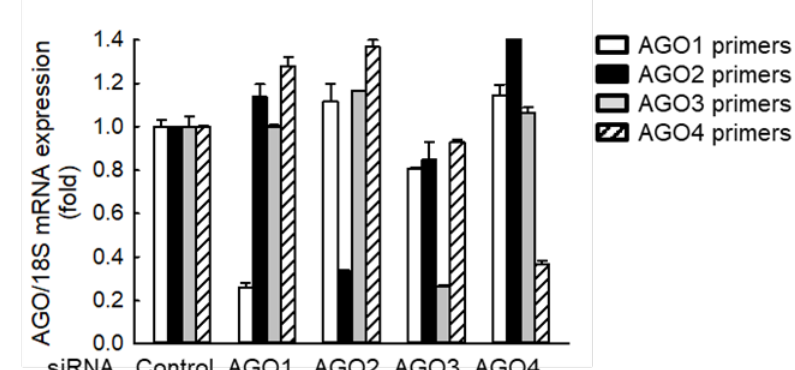
Figure 1. AGO1 and 4 knockdown inhibit RSV-induced tRF5-GluCTC activity. ( A ) A549 cells in triplicate were transfected with 100 nmol/l of siRNA against human AGO1, 2, 3, or 4, or scrambled siRNA (Control) as a negative control in the presence of Pp -anti_GluCTC sensor and renilla ( Rr ) plasmids. At 6 h post-transfection, cells were mock- or RSV-infected at a multiplicity of infection (MOI) of 3 and then harvested at 15 h post-infection (p.i.) to measure luciferase activities. Pp luciferase values were normalized to Rr luciferase values. Data are representative of 3 – 4 independent experiments and expressed as means ± SE. * p < 0.05, relative to the paired white bar. ( B ) Cells were transfected with control or each AGO-specific siRNA as described in ( A ). At 24 h post-transfection, total RNA was prepared, followed by cDNA synthesis and qRT-PCR using each AGO-specific primer. AGO expression was normalized to that of 18S mRNA. Data are representative of three independent experiments and expressed as means ± SE.